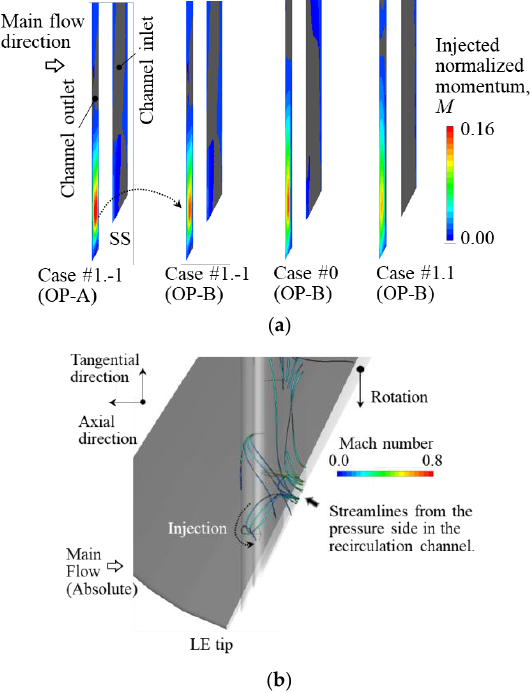
Figure 8. Distributions of the normalized momentum injected in the axial direction. View from above the casing, approximately in the cascade plane. ( a ) Distribution of the injected normalized momentum in the axial direction at the inlet and at the outlet of the RC. ( b ) Absolute velocity streamlines inside the recirculation channel (Case #1.-1, OP-A, top view).